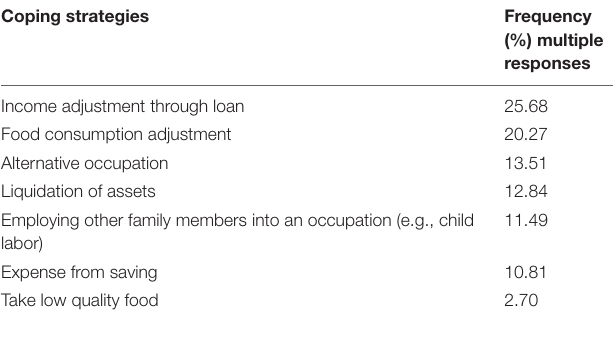
TABLE 9 | Coping strategies during the ban season by the participants in fisher